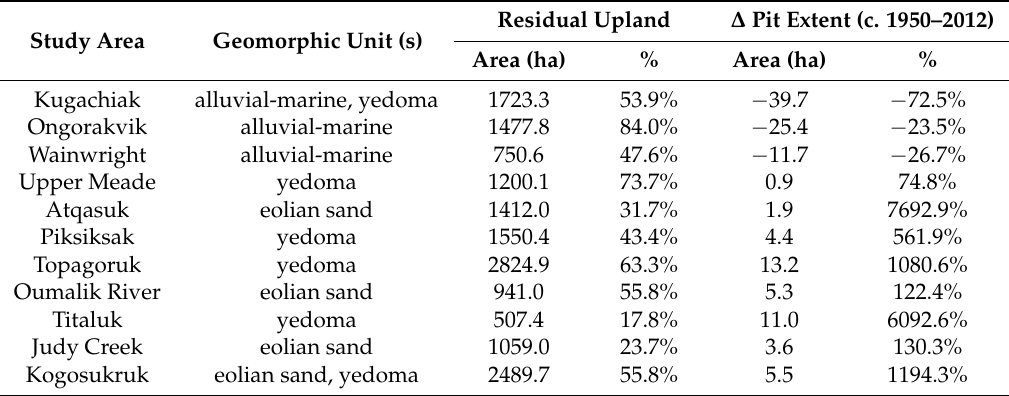
Table 3. Summary of residual upland extent (ha) and the change in thaw-pit extent from c. 1950 to c. 2012 on an areal and percentage basis by study area, North Slope,